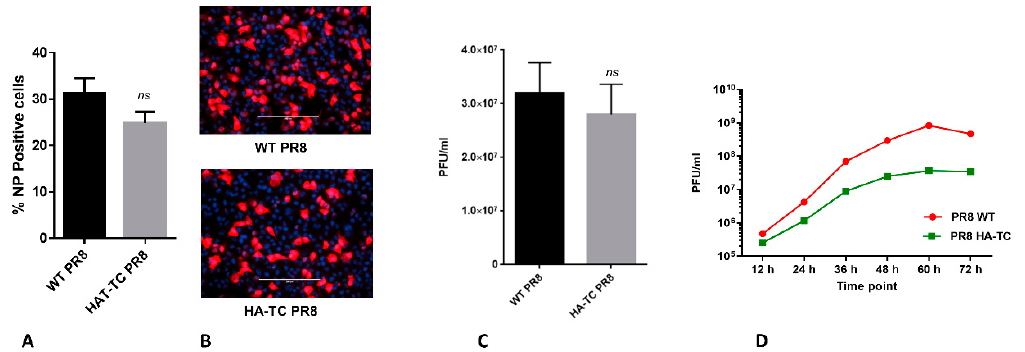
Figure 2. Rescue and characterization of reporter IAV expressing HA-TC protein: ( A , B ) Madin–Darby canine kidney (MDCK) cells were infected with WT or HA-TC PR8 IAV at MOI of 5 and 3 h post infection immunostaining was performed using anti-NP specific primary and alexa-568 (red) secondary. Nuclei were co-stained with DAPI (Blue). NP positive cells were counted from 5 independent fields and ratio over DAPI positive cells was calculated. Percentage NP positive cells were plotted on the graph. ( C ) MDCK cells were infected with WT and HA-TC PR8 IAV at MOI of 1. After 16 h post infection, culture supernatant was harvested, and virus titer was measured by plaque assay. The titers were plotted on the graph. ( D ) In a time course experiment, MDCK cells were infected with WT or HA-TC PR8 IAV at MOI of 0.02. Culture supernatants were collected at 12h intervals up to 72 h. Virus titer was measured by plaque assay, and mean titers were plotted on the graph. Data show mean ± S.D. from representative experiment ( n = 3) of at least three independent experiments.